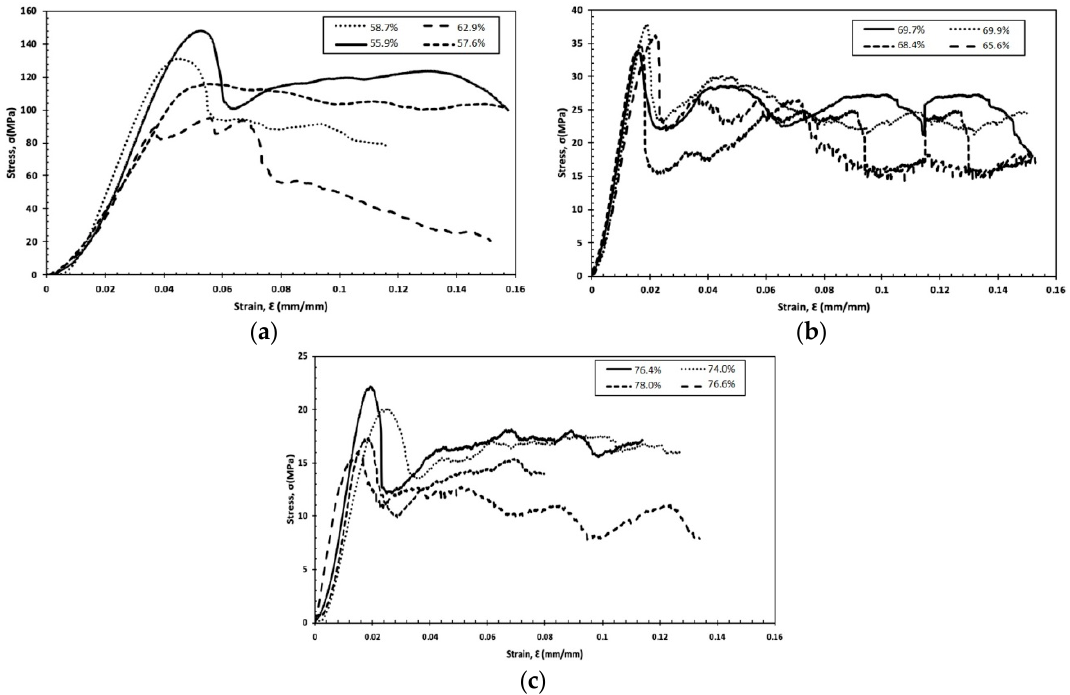
Figure 7. Compressive stress–strain curves of porous Ti samples with three different porosity